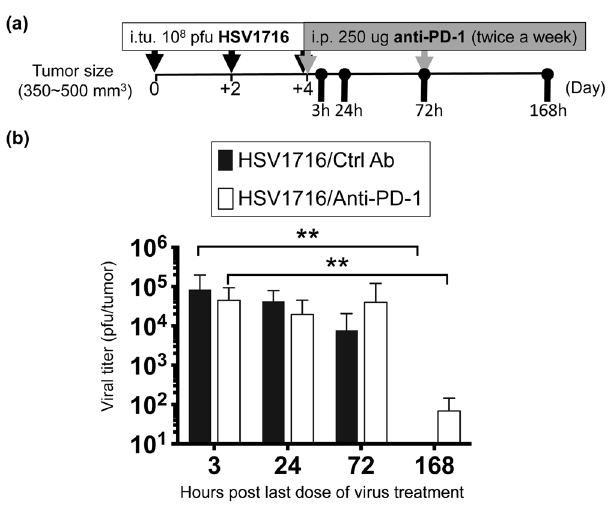
Figure 4. PD-1 blockade does not significantly alter intratumoral viral kinetics. ( a ) Schematic illustrates the dosing regimens and sample collection. Female M3-9-M tumor-bearing mice were treated with three doses of 1 × 10 8 pfu of HSV1716 intratumorally (i.tu.) followed by intraperitoneal (i.p.) injection of anti-PD-1 or control antibody. Tumors were harvested 3, 24, 72 and 168 hours after last dose of HSV1716 injection for plaque assays. ( b ) Data are expressed as total plaque-forming units (pfu) per tumor with error bars representing SD (n = 6 per treatment group). Statistical analysis was performed by a one-way ANOVA with Tukey-adjusted post hoc tests ( ** p <